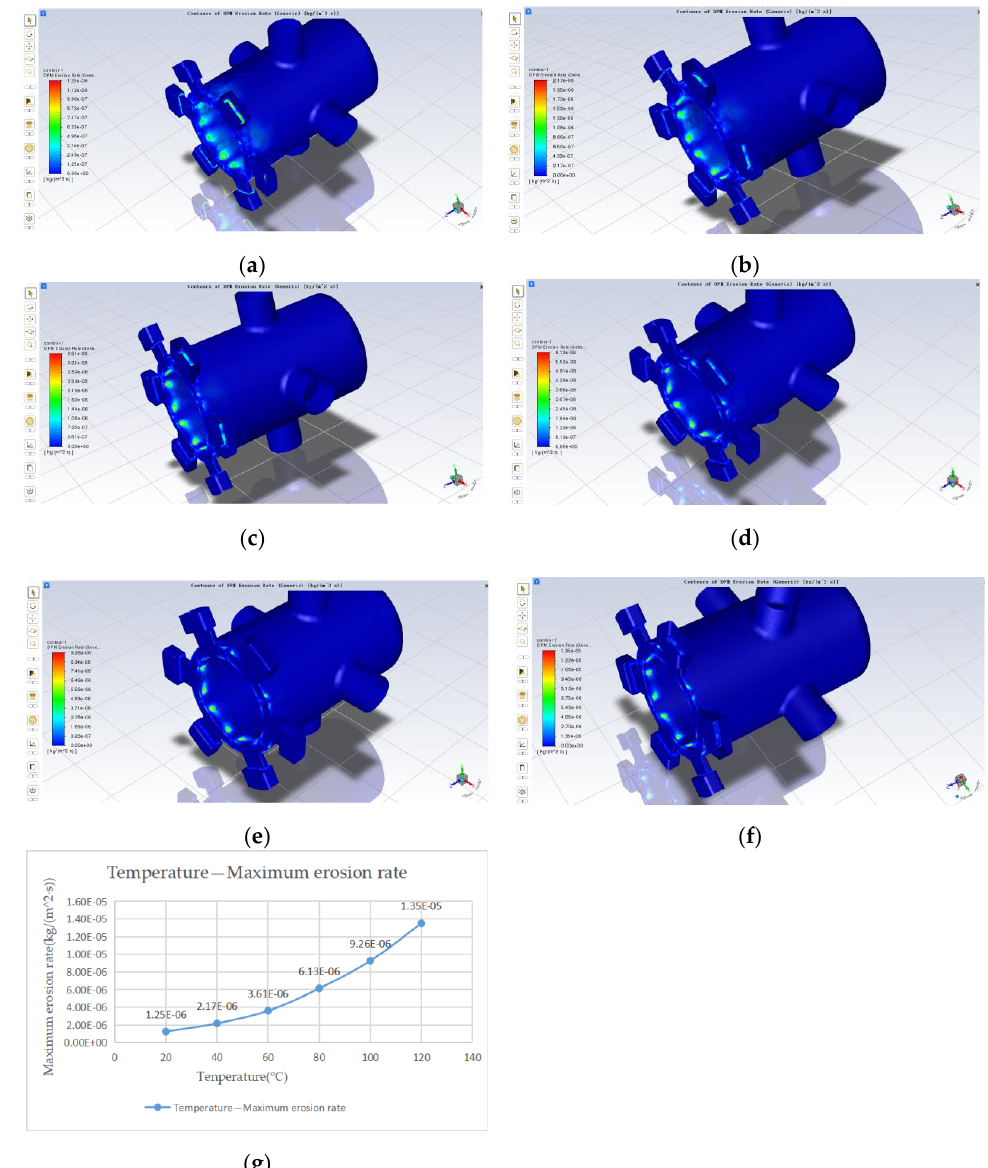
Figure 8. Effect of oil temperature on erosion rates: ( a ) 20 °C ; ( b ) 40 °C ; ( c ) 60 °C ; ( d ) 80 °C ; ( e ) 100 °C ; ( f ) 120 °C ; ( g ) graph of erosion rate as a function of temperature.